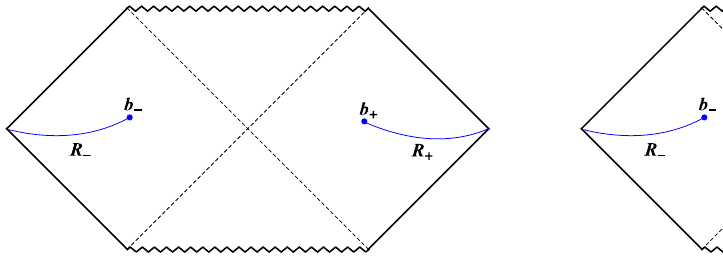
represent the boundaries (cutoff surfaces) of R − and R + , respectively. I refers to the island, extending between the left and right wedges, whose boundaries are denoted by a